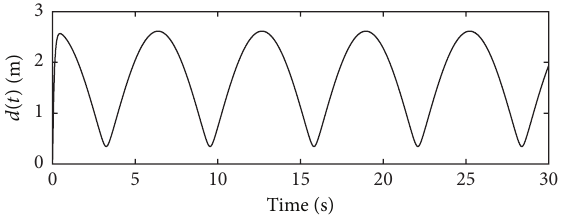
Figure 2: Following distance without